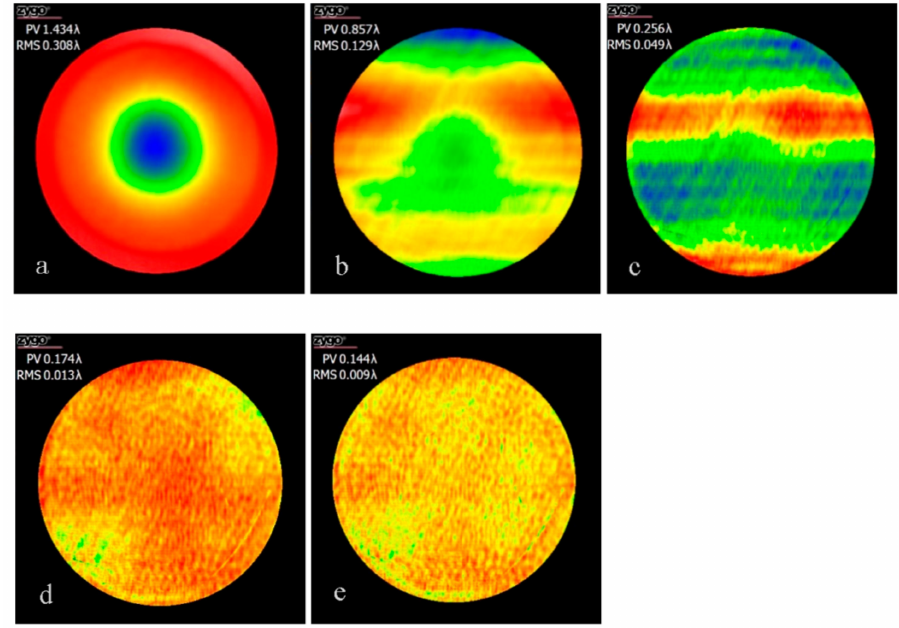
Figure 9. Form error maps after processing. ( a ) Initial form error map, ( b ) first form error map after processing for 95 min, ( c ) second form error map after processing for 64 min, ( d ) third form error map after processing for 18 min, ( e ) fourth form error map after processing for 9